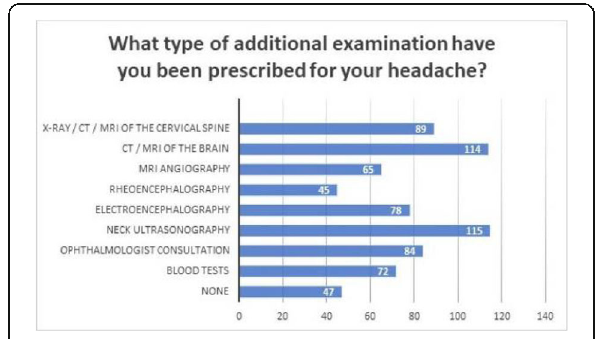
Fig. 1 (abstract P0403). See text for description